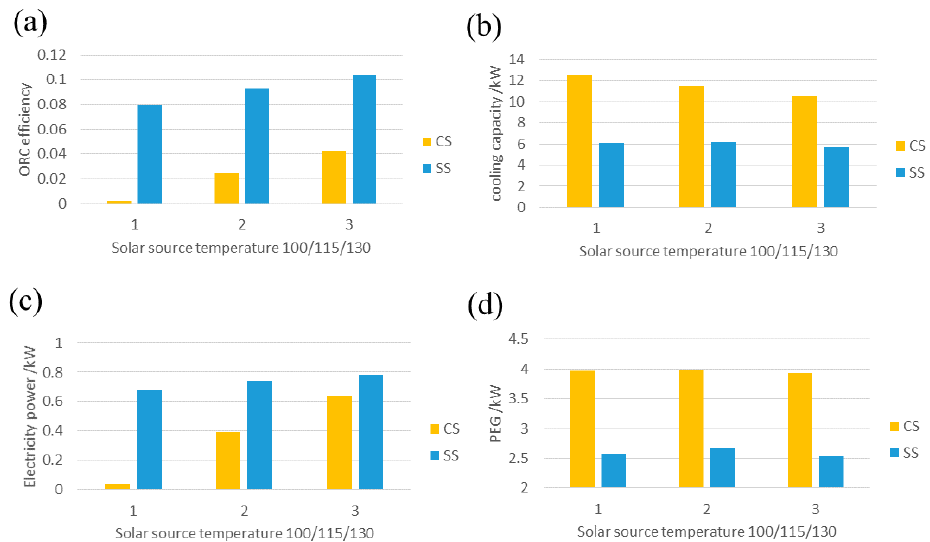
Figure 4. ( a ) ORC efficiency, ( b ) cooling output capacity, ( c ) electricity generation and ( d ) primary energy efficiency for the CCHP systems under different solar collecting temperature with R141b as ORC working fluids in cooling mode.